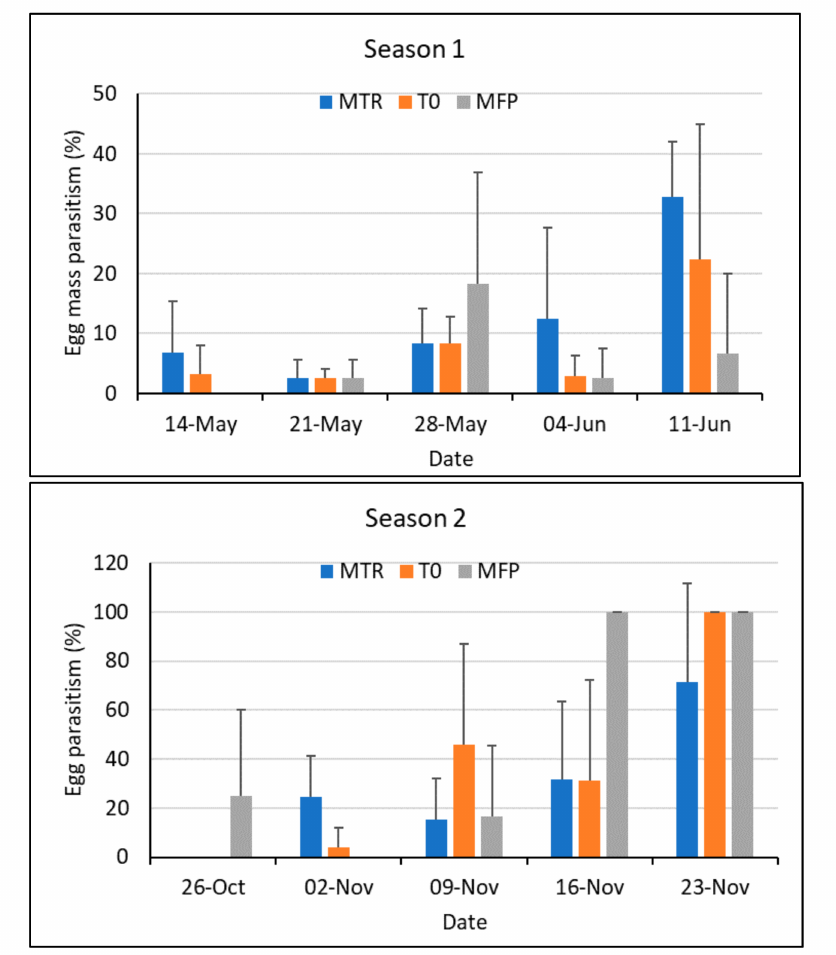
Figure 4. Mean (+SD) egg mass parasitism by T. remus in the major ( Season 1 ) and minor ( Season 2 ) rainy seasons in Ghana in 2020. MTR = T. remus release plots; T0 = plots without T. remus releases, no pest control; MFP = farmers’ conventional practice including chemical pest control; 4 replicates per treatment and